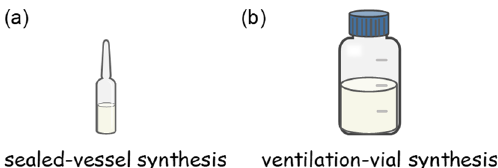
Figure 1. Schematic illustration of ( a ) sealed-vessel and ( b ) ventilation-vial synthesis methods. Using the sealed-vessel and ventilation-vial synthesis methods, the crystallinity of the COF-300 products for different reaction times were monitored with powder X-ray diffraction (PXRD), and then the yields of the crystalline products were determined (Table